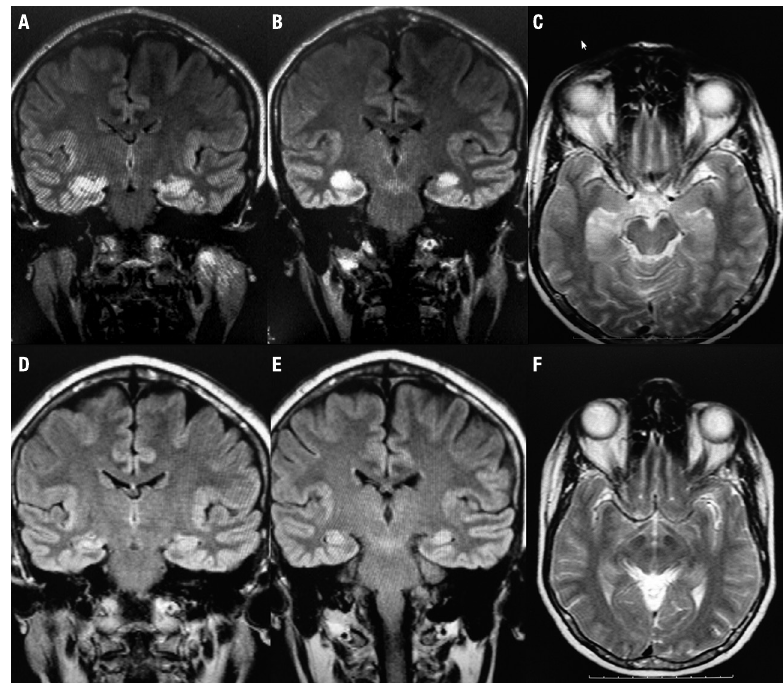
Figure 1. [A, B] Coronal flair, [C] Axial T2WI. [A, B] Bilateral hipocampi hyperintense sign at clinical onset of symptoms. [C] The same signal is already present on axial T2 sequence. [D, E] Coronal flair, [F] Axial T2Wi. [D, E] Later in the follow up (220 days af- ter), MRI has an improvement. [F] The patient’s total recovery is showed.